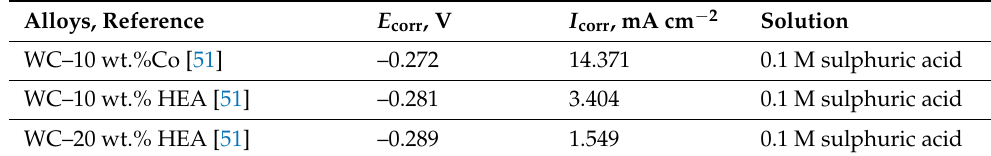
Table 2. Electrochemical corrosion parameters of WC-based cemented carbides with Co and HEA binders